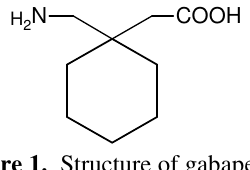
Figure 1. Structure of